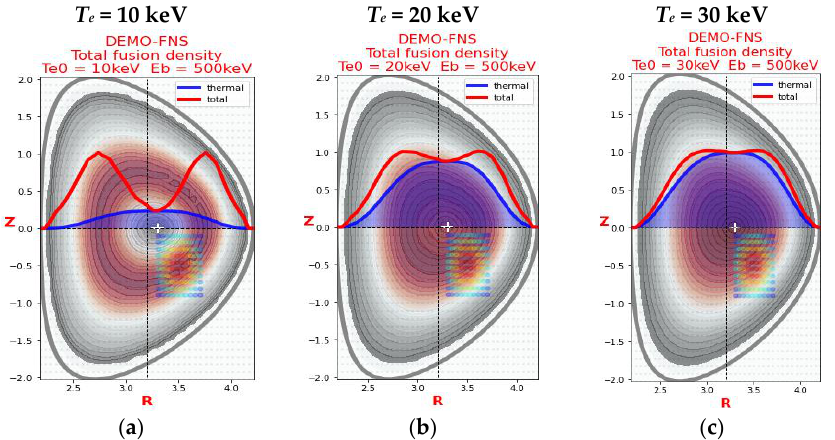
Figure 7. Plasma temperature impact on thermal fusion rate share in DEMO-FNS plasma: ( a ) T e = 10 keV; ( b ) T e = 20 keV; ( c ) T e = 30 keV. NBI tangent position R inj /Z inj = 3.5/ − 0.5 m; n e = 1 × 10 20 m − 3 , E b = 500 keV. Thermal fusion reactivity profile (blue) and total fusion